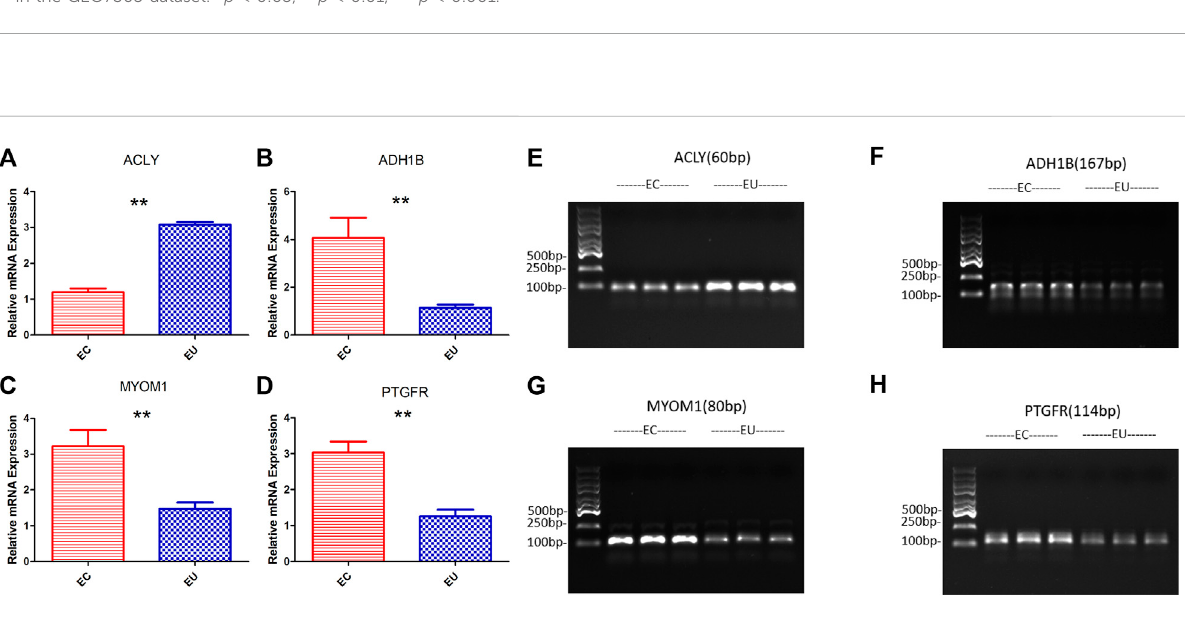
FIGURE 5 TheresultsofRT-PCRandthegraphs(CTcurves)toverifytheexpressionofcharacteristicgenesatthemRNAlevel; (A) , (E) ACLY; (B) , (F) ADH1B; (C) , (G) MYOM1; (D) , (H) PTGFR; ** p <